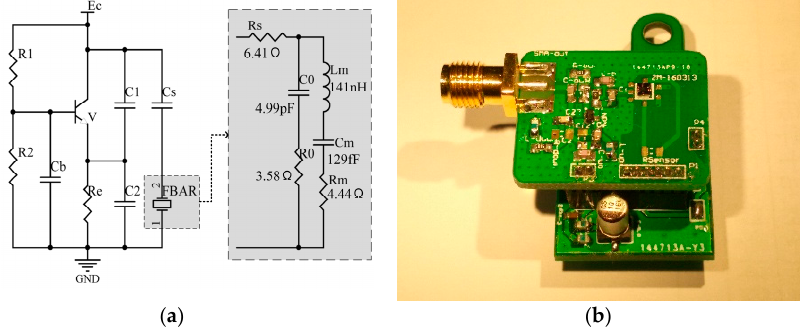
Figure 5. ( a ) Schematic diagram of the oscillator circuit and ( b ) the photo of a sensor sample.